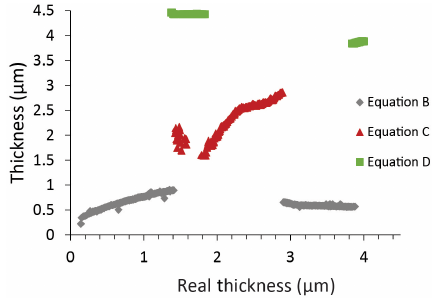
Figure 7. Relationship between measured thickness (with tilting compensator) of the ETH-W2 calcite wedge and thickness cal- culated by application of the equations of Beaufort et al. (2014) for calculation of calcite thickness from HSL color model, for the validation dataset from the calcite wedge. The colors indicate the equation specified for use according to the criteria of Beaufort et al.